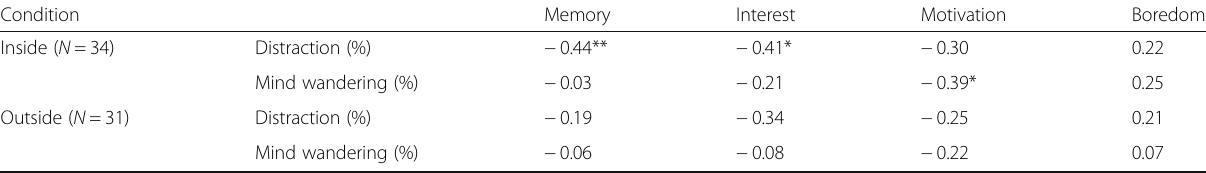
Table 2 Correlation table split by condition Condition Memory Interest Motivation